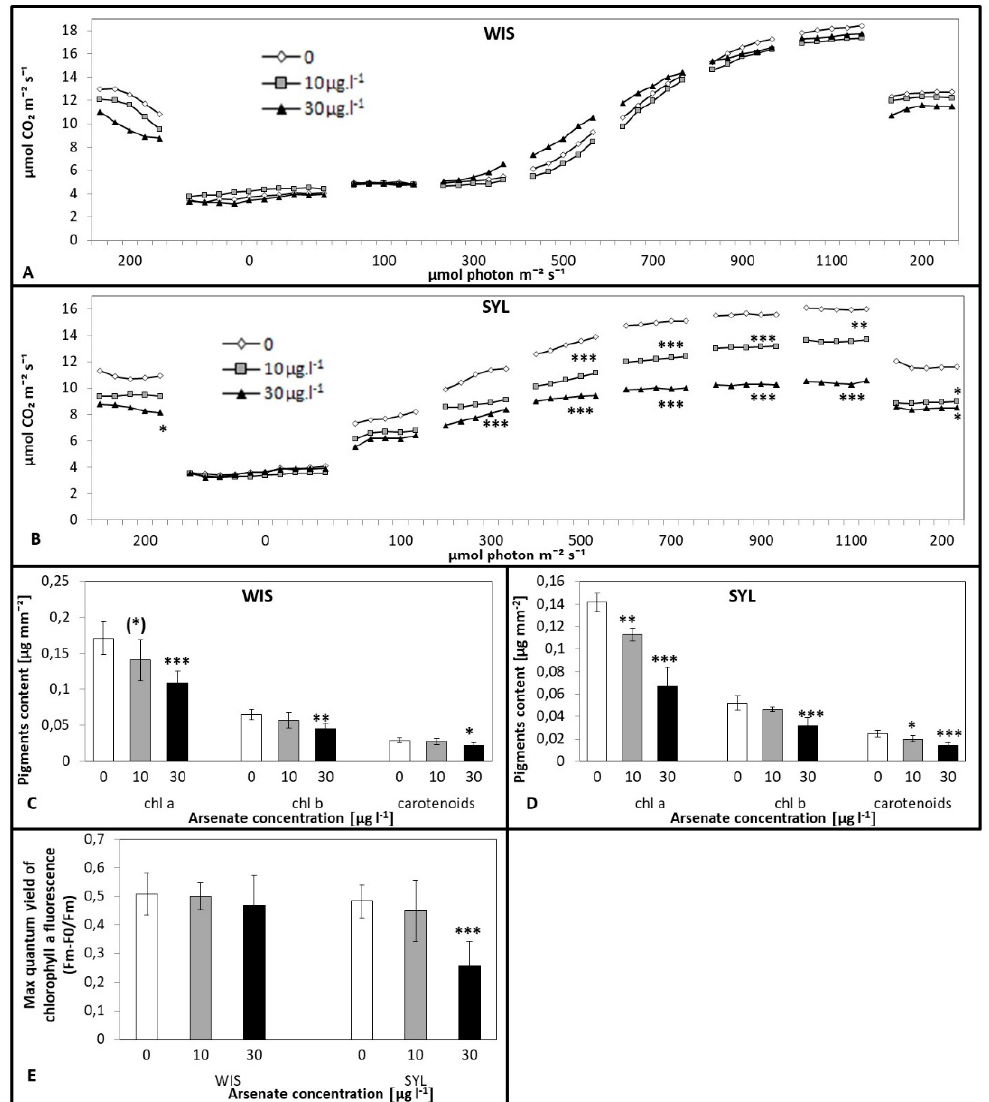
Figure 2. Effects of arsenic on the net photosynthesis rate under different irradiances ( A,B ), pigments contents ( C,D ), and chlorophyll a fluorescence ( E ) in two contrasting tobacco genotypes ( A,C tolerant